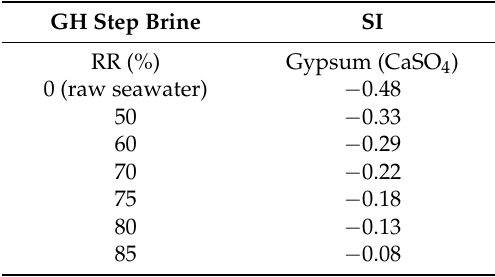
Figure 2. Average retentate characteristics obtained in the dense UF step as a function of recovery ratio (membrane: GH; n = 3). Table 1. CaSO 4 saturation index (SI) in the retentate produced in the dense UF step as a function of the recovery ratio, calculations made using PHREEQC interactive 3.3.10-12220 [18].